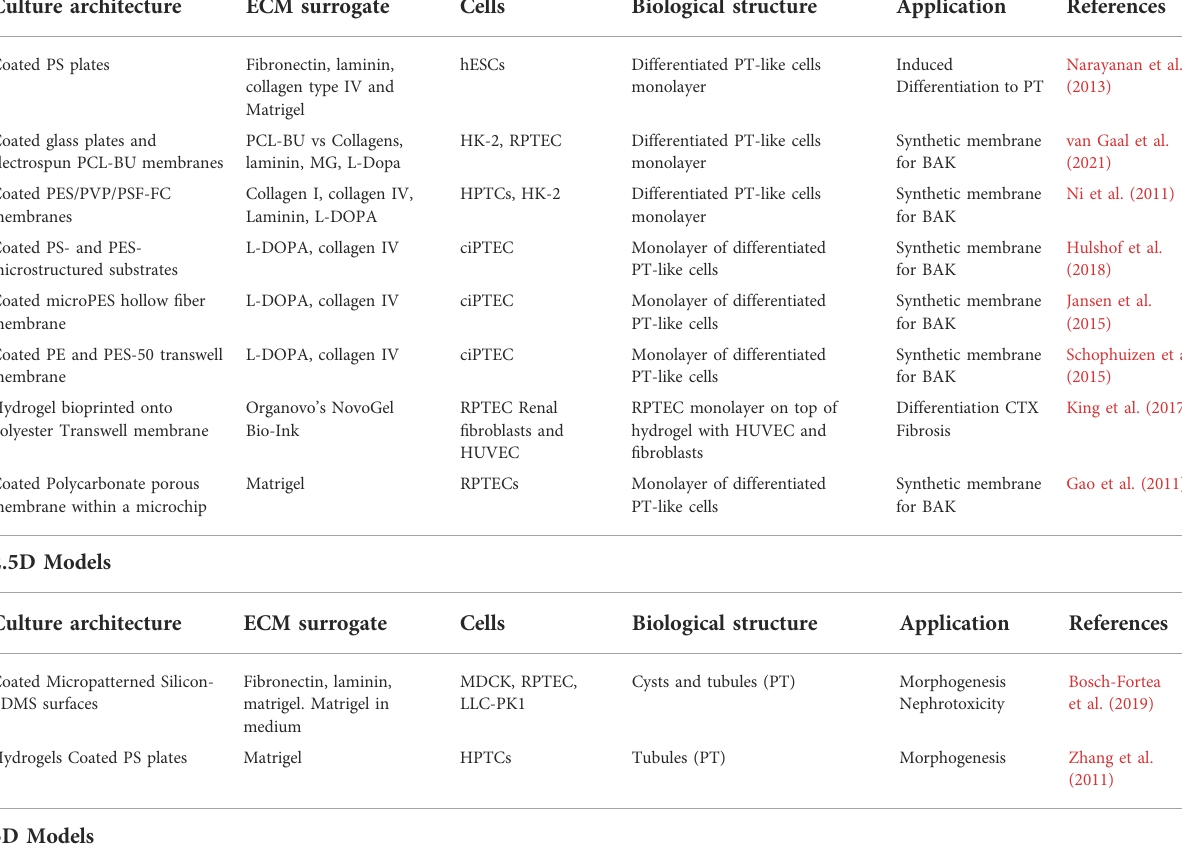
TABLE 1 Role of ECM in in vitro models of renal function and